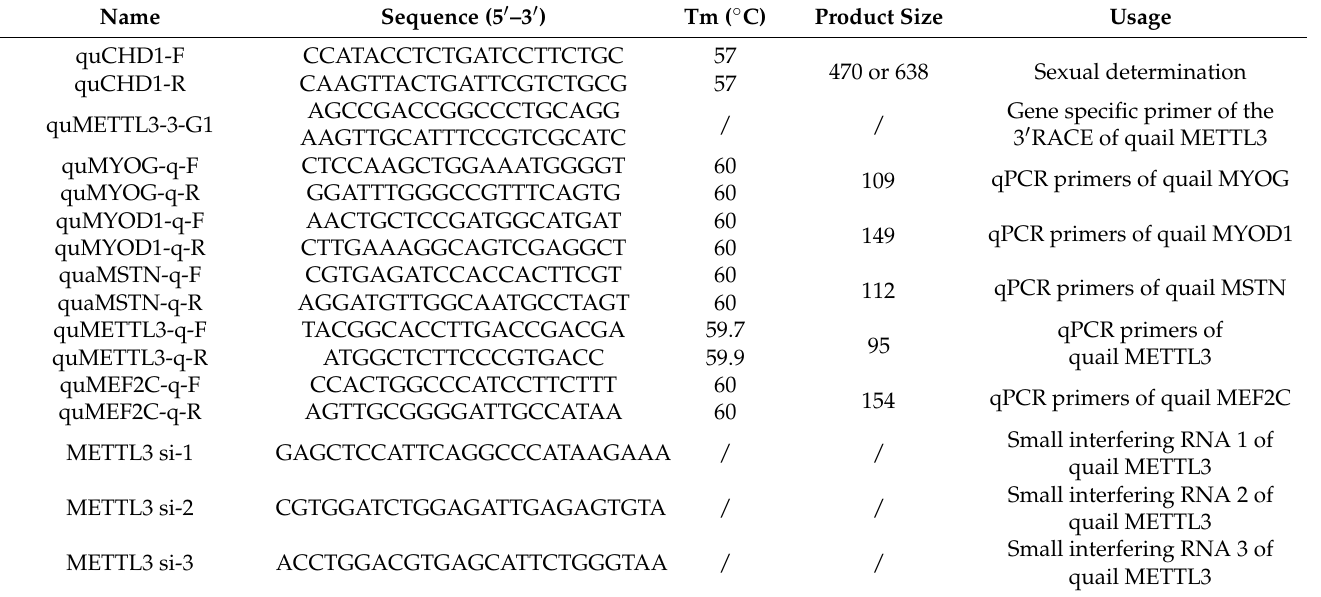
Table 1. The information of primers and small interfering